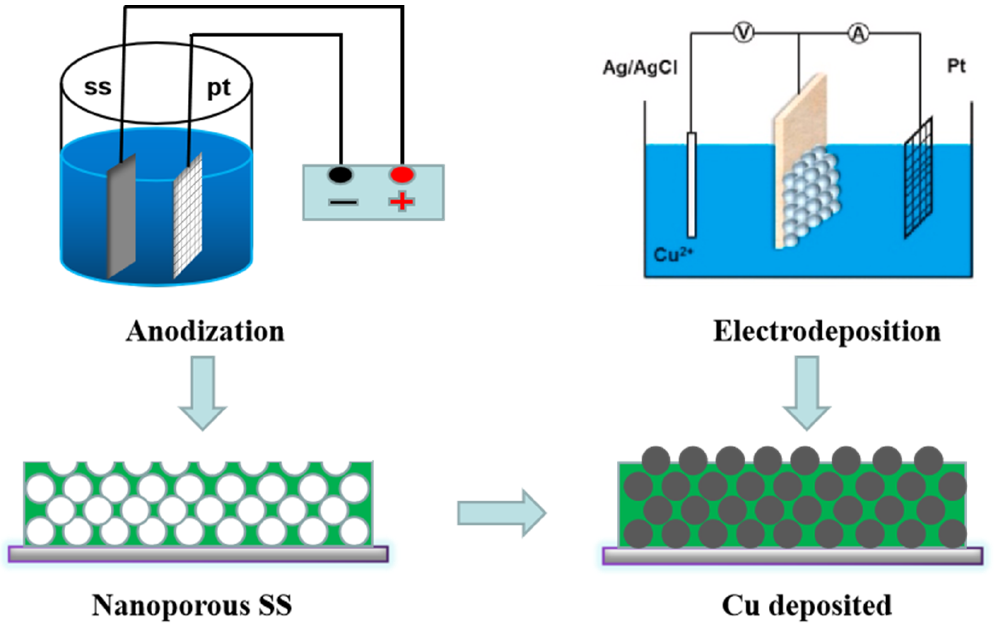
Figure 1. Procedure diagram for preparing NPSS and Cu/NPSS.